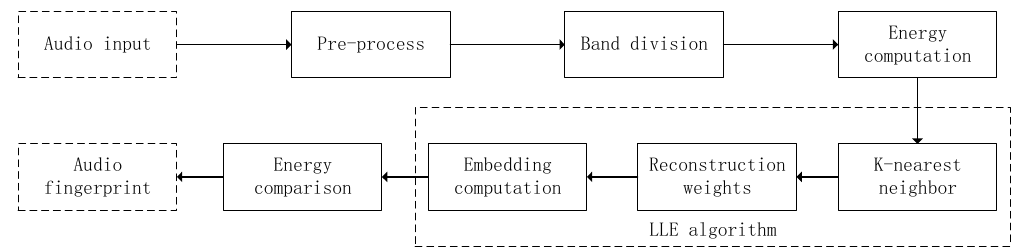
Figure 2. Block diagram of audio fingerprint extraction based on LLE.